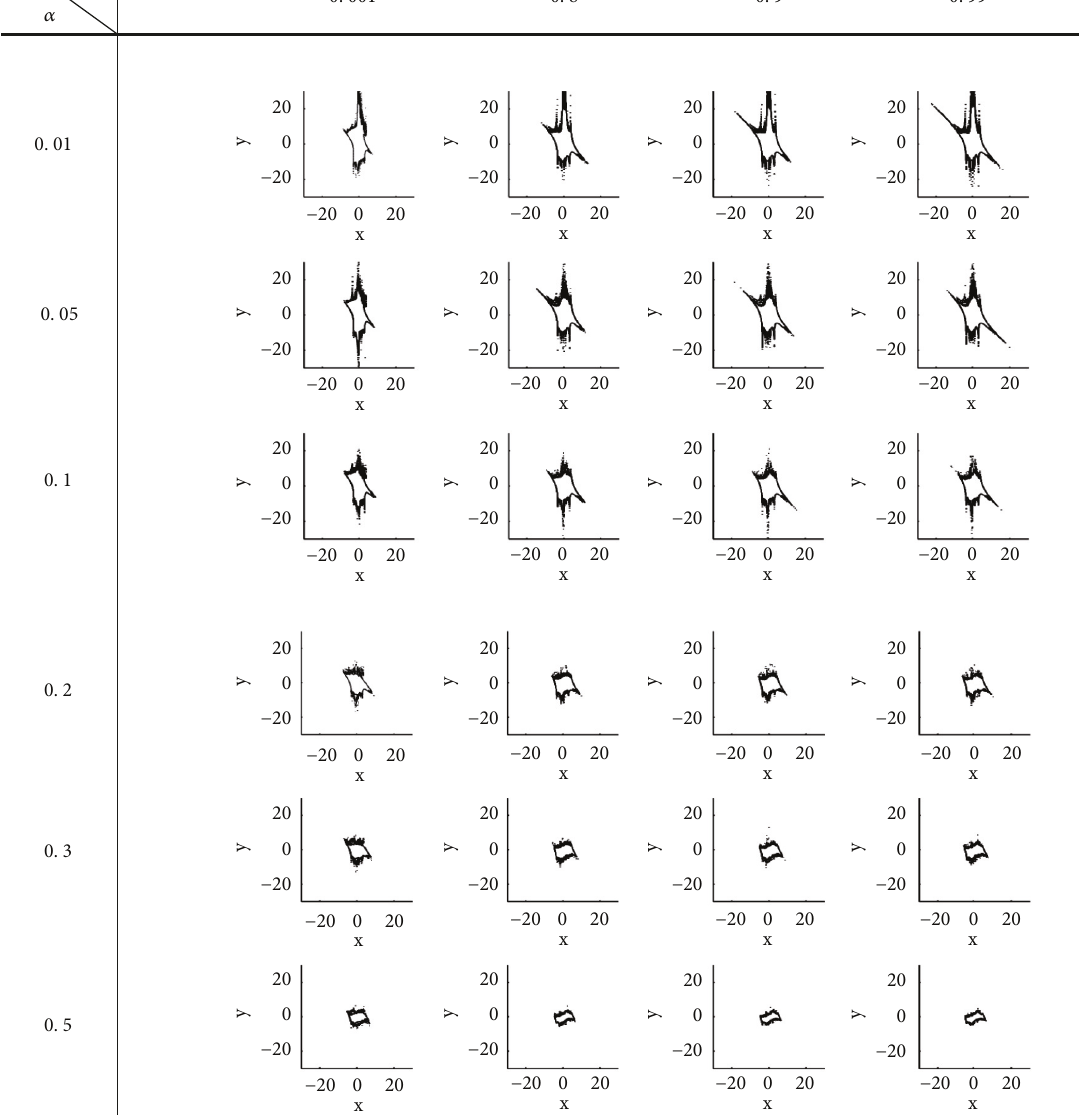
Figure 5: The change of Julia sets of the controlled system (18) when ( a ) 𝛼 = 0.01; ( b ) 𝛼 = 0.05; ( c ) 𝛼 = 0.1; ( d ) 𝛼 = 0.2; ( e ) 𝛼 = 0.3; ( f ) 𝛼 = 0.5 and 𝜇 = 0.001, 0.8, 0.9, 0.99 .